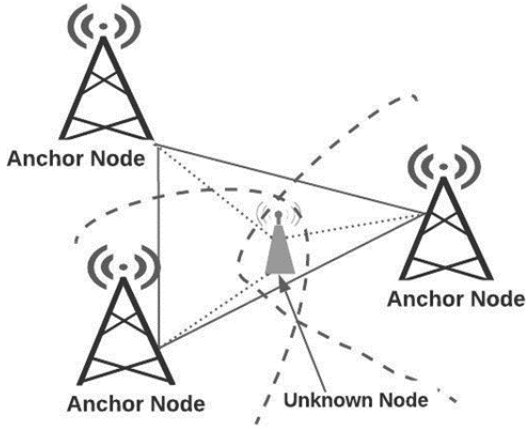
Figure 5. Time difference of arrival.